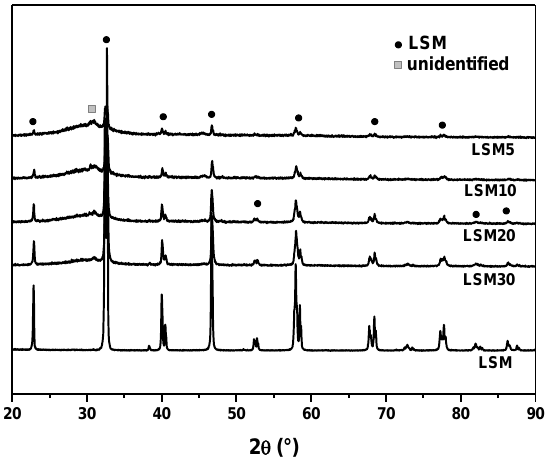
Figure 6. XRD patterns of the composites analyzed.